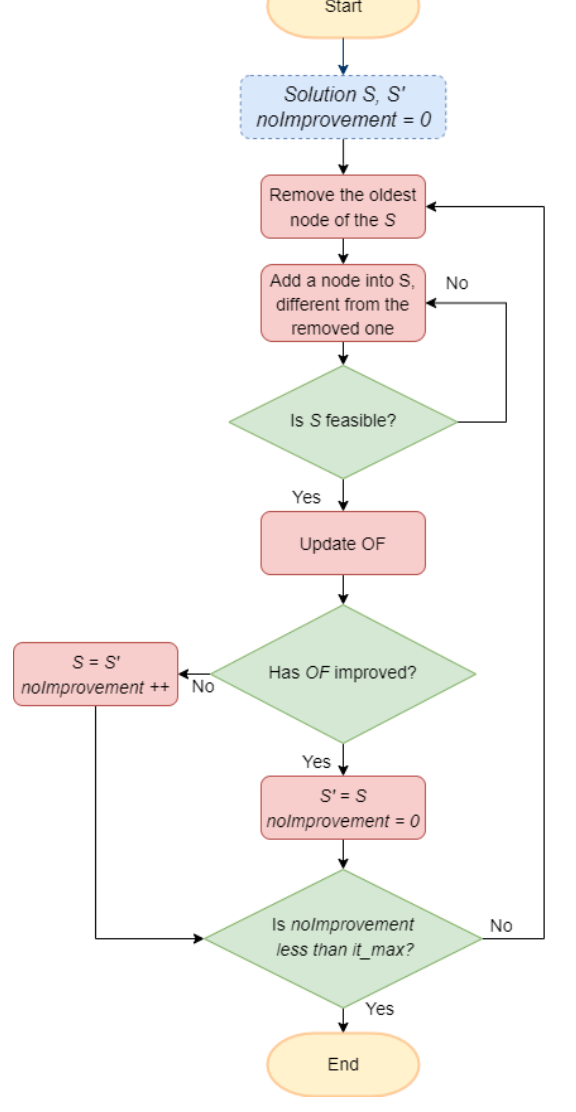
Figure 3. Local search